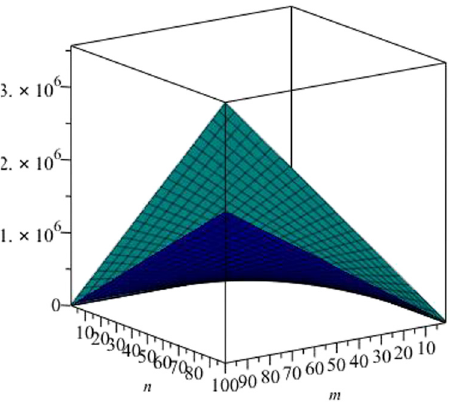
Figure 5: Comparison of K - hyper Banhatti HB 1 and K - hyper Banhatti HB 2 indices.